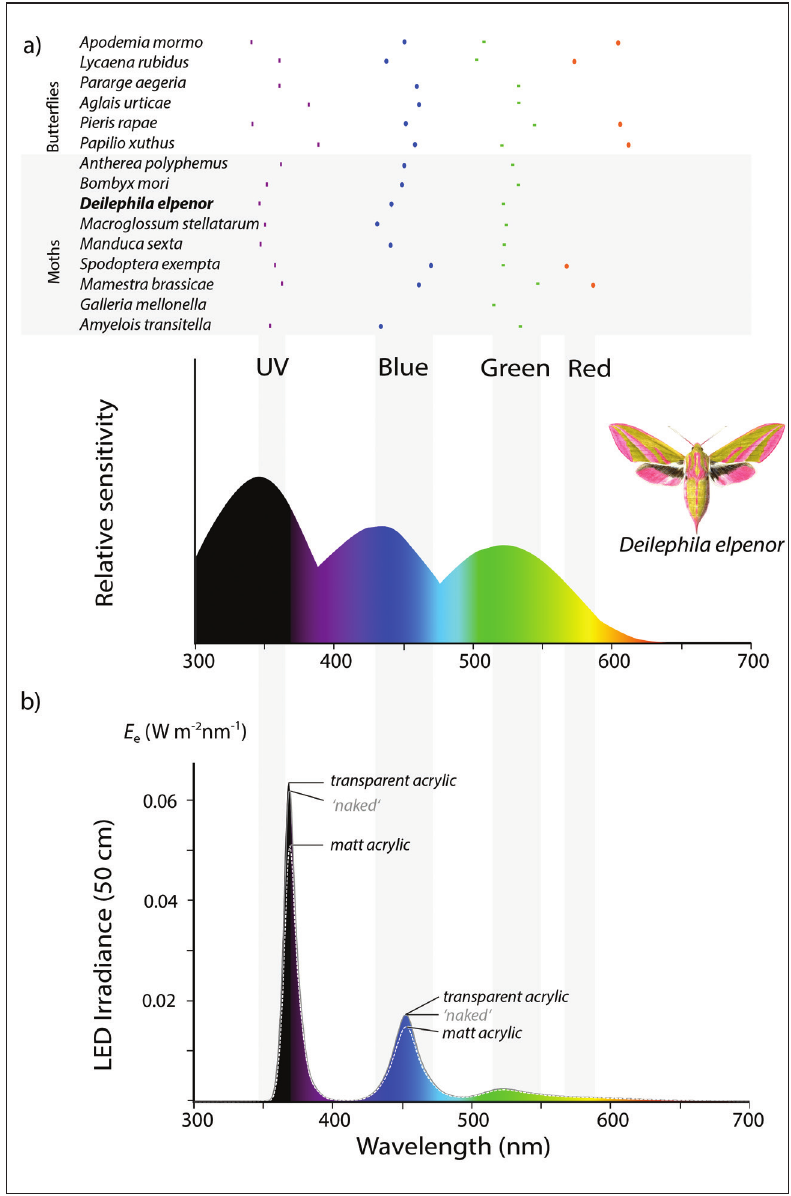
Figure 1. a. Values of maximum spectral sensitivity of Lepidoptera eyes, modified from Briscoe and Chittka (2001) and Johnsen et al. (2006), and sensitivities of the photoreceptors of the hawk moth Deilephila elpe- nor as an example, with peak absorption wavelengths of 350, 440, and 525 nm (Johnsen et al. 2006). b. The spectral composition of the new LED lamp (operated at 350 mA) is oriented towards the spectral sensitivity of moth eye receptors (background grey bars). A transparent acrylic cylinder has only a minimal influence on the irradiation from the lamp whereas a matt acrylic cylinder (dashed white line) slightly decreases the performance of the lamp, see also Table